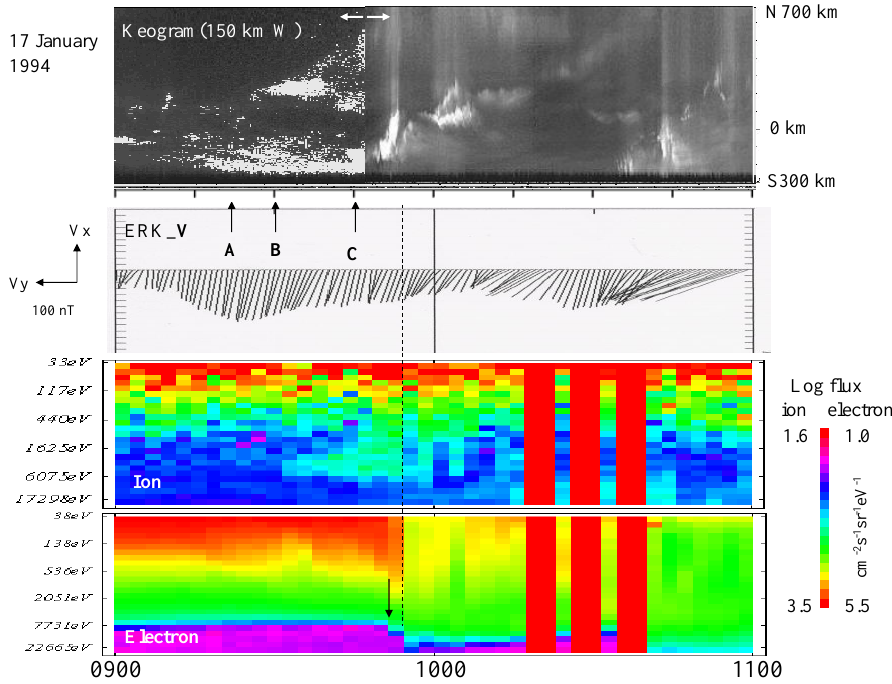
Figure 3. Same as Fig. 1, but showing a keogram (150km W), the polar cap convections from ERK (88.7 ◦ ILAT), the ion spectrogram from 33eV to 17.3keV, and the electrons from 38eV to 22.7keV. In the keogram, the auroras above 0.305 in the gray level (0 for black and 1 for white) were highlighted in bright white before 09:47UT (marked by arrows), while the gray level in Fig. 1 is used after 09:47UT. The polar cap convection is plotted in the sun–earth coordinates (see text). Vx denotes sunward, Vy denotes duskward. The time resolution is 1min. The vertical line in the velocity plots denotes the time mark at 10:00UT. A spin-averaged flux in cm − 2 s − 1 sr − 1 eV − 1 obtained in one ∼ 10s spin with repetition interval of ∼ 3min is plotted. Logarithmic scales for the ion and the electron flux are to the right. Thick red vertical lines in the ion and the electron spectrogram denote data gaps. The arrow in the fourth panel denotes a step-like increase of the upper cutoff energies of the plasma-sheet electrons (see